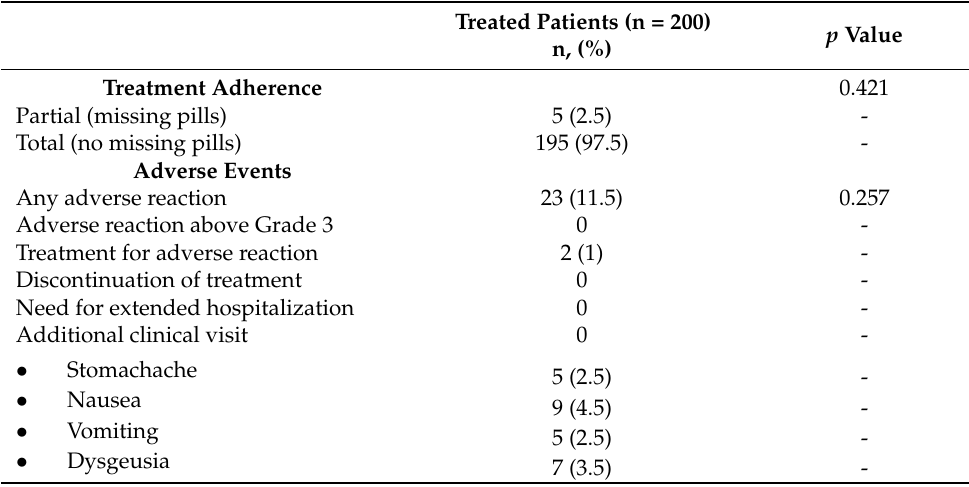
Table 2. Treatment adherence and adverse events in patients treated with nirmatrelvir/ritonavir (Group A, n =